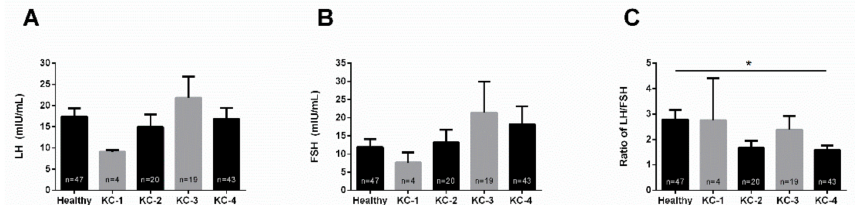
Figure 5. Severity-dependent expression of LH and FSH, and the LH / FSH ratio in healthy (n = 47) and KC (n = 86) blood (plasma) samples. Severity grades were defined based on the Kmax: KC-1 (n = 4), KC-2 (n = 20), KC-3 (n = 19) and KC-4 (n = 43). ( A ) LH levels in healthy controls and KCs, across all severities, ( B ) FSH levels in healthy controls and KCs, across all severities, and ( C ) the LH / FSH ratio in healthy controls and KCs, across all severities. * p < 0.05. (See Supplementary Materials—Figure